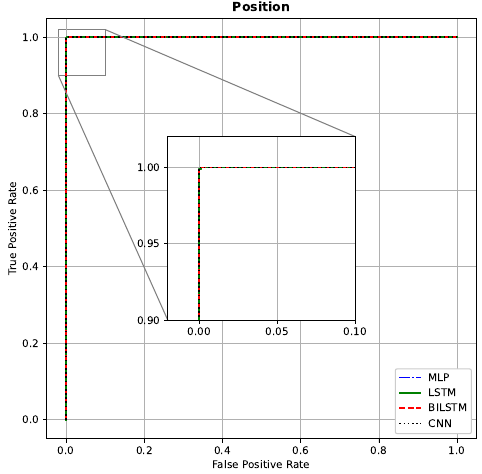
Figure 11. Comparison of failure